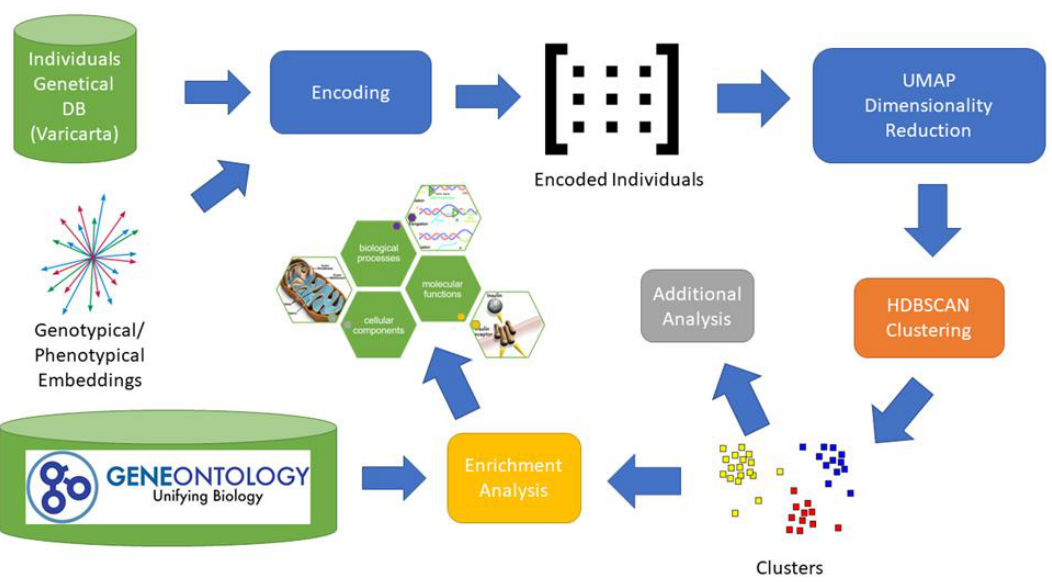
Figure 1. Analysis Process. The image depicts the entire process adopted to identify potential subgroups of individuals with ASD. For each individual included in the VariCarta database, the set of variated genes is selected and then encoded using the genotypical/phenotypical embedding space. Each individual is then represented with a 64-component vector in the genotypical/phenotypical embedding space. Dimensionality reduction is applied to the encoded individuals’ matrix to reduce clustering complexity. The genes of the resulting clusters are then used for the enrichment and endophenotype analysis.